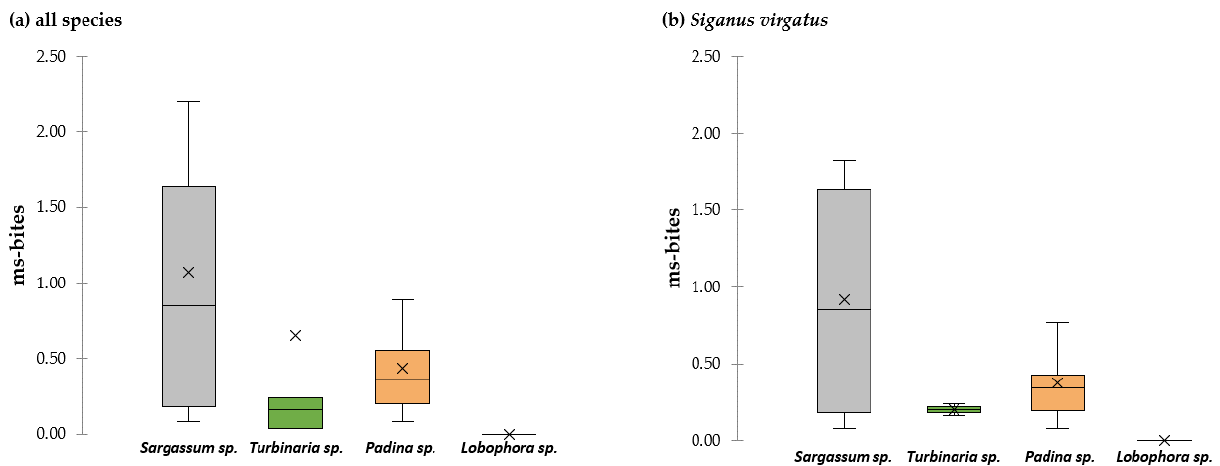
Figure 6. Ms-bites in multiple-choice assays (loc D) in the reef flat in 2018 taken on the four offered macroalgae genera ( Sargassum , Padina , Turbinaria and Lobophora ) for all fish species ( a ) and for the most dominant browser S. virgatus ( b ). No bites on Lobophora were recorded. The boxplot shows the median and 25% quantile, the black cross indicates the mean. Table 3. Strauss’ Linear Selection Index ( L ) tested for positive or negative selection of the four offered algae genera Sargassum, Padina, Turbinaria and Lobophora by S. virgatus in multiple-choice assays in the reef flat (loc D) in 2018. R i is the proportion of the i -th food type consumed and P i is the proportion of the i -th food type available in the environment.